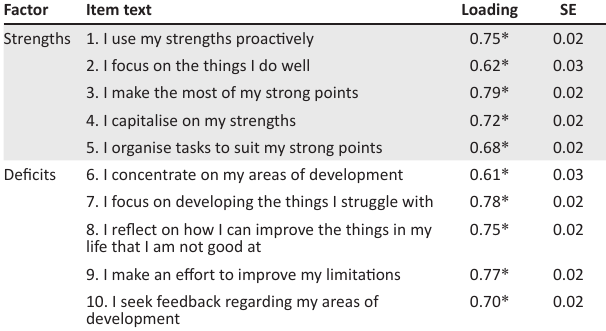
TABLE 2: Standardised factor loadings of the items for the latent